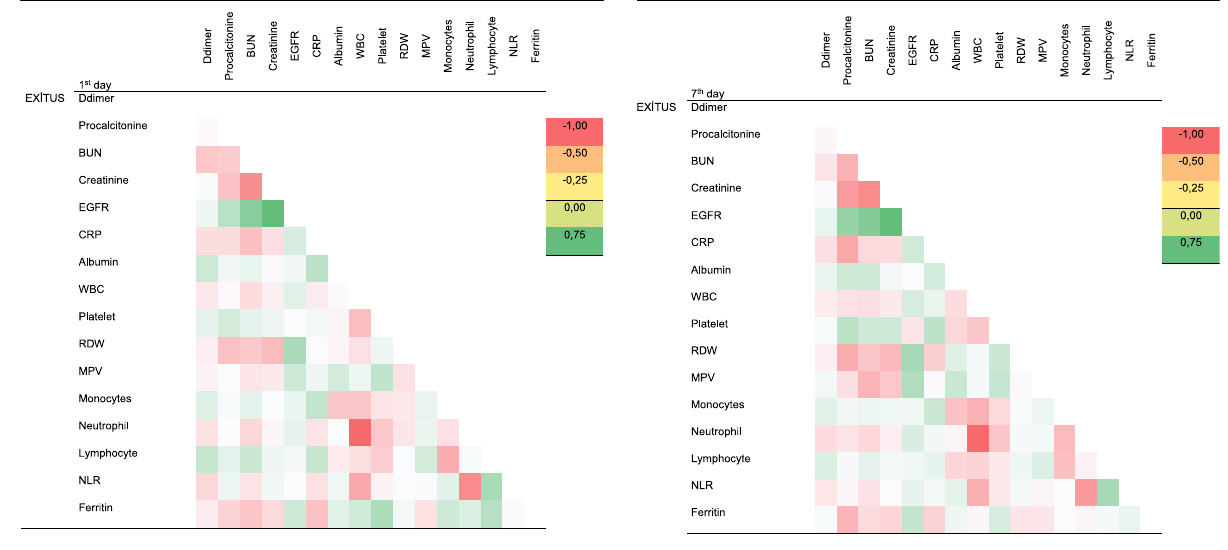
Table  : Correlation analysis of day  st variables of cases with mortality (Heat map correlation matrix between biochemical markers).